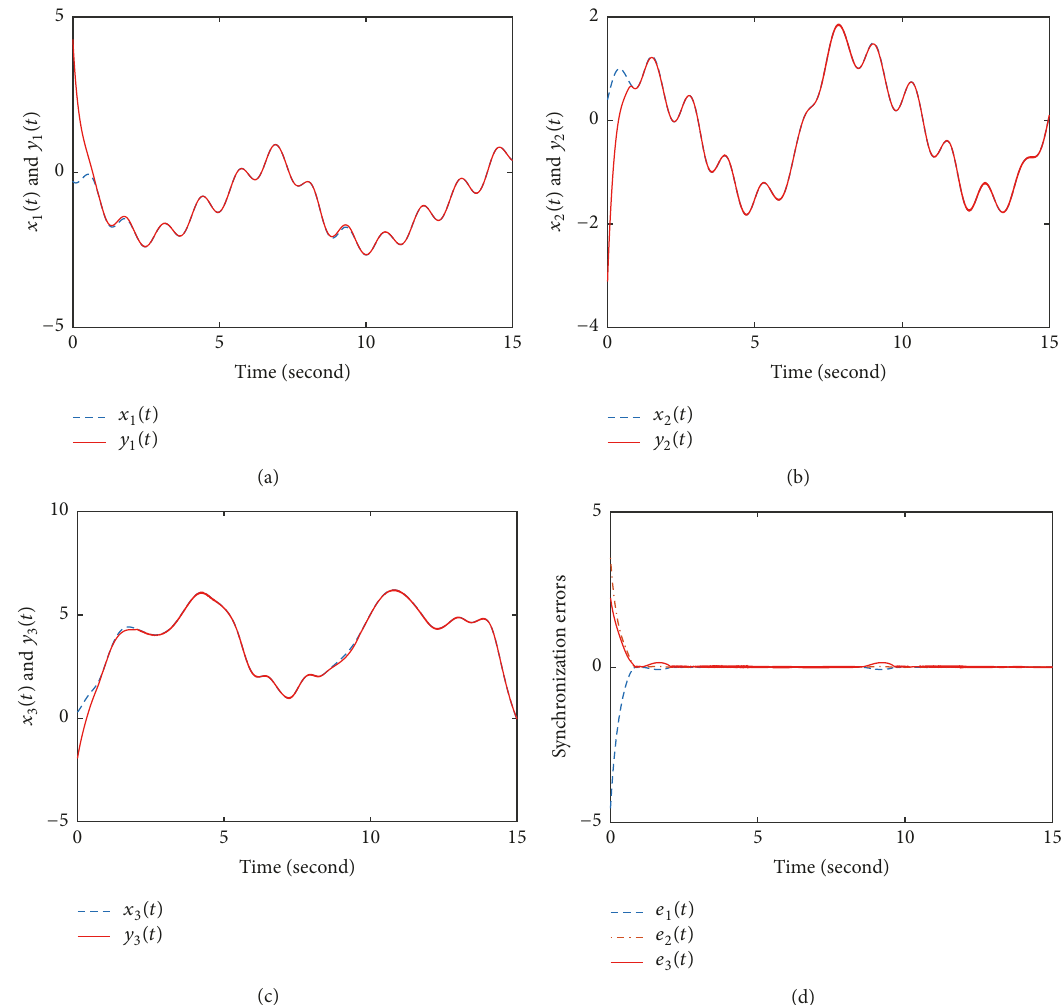
Figure 7: Simulation results when 𝑢(𝑡) = [5 sin (20𝑡),3 cos (20𝑡),4 sin (10𝑡)] 𝑇 in (a) 𝑥 1 (𝑡) and ̂𝑥 1 (𝑡) ; (b) 𝑥 2 (𝑡) and ̂𝑥 2 (𝑡) ; (c) 𝑥 3 (𝑡) and ̂𝑥 3 (𝑡) ; (d) synchronization